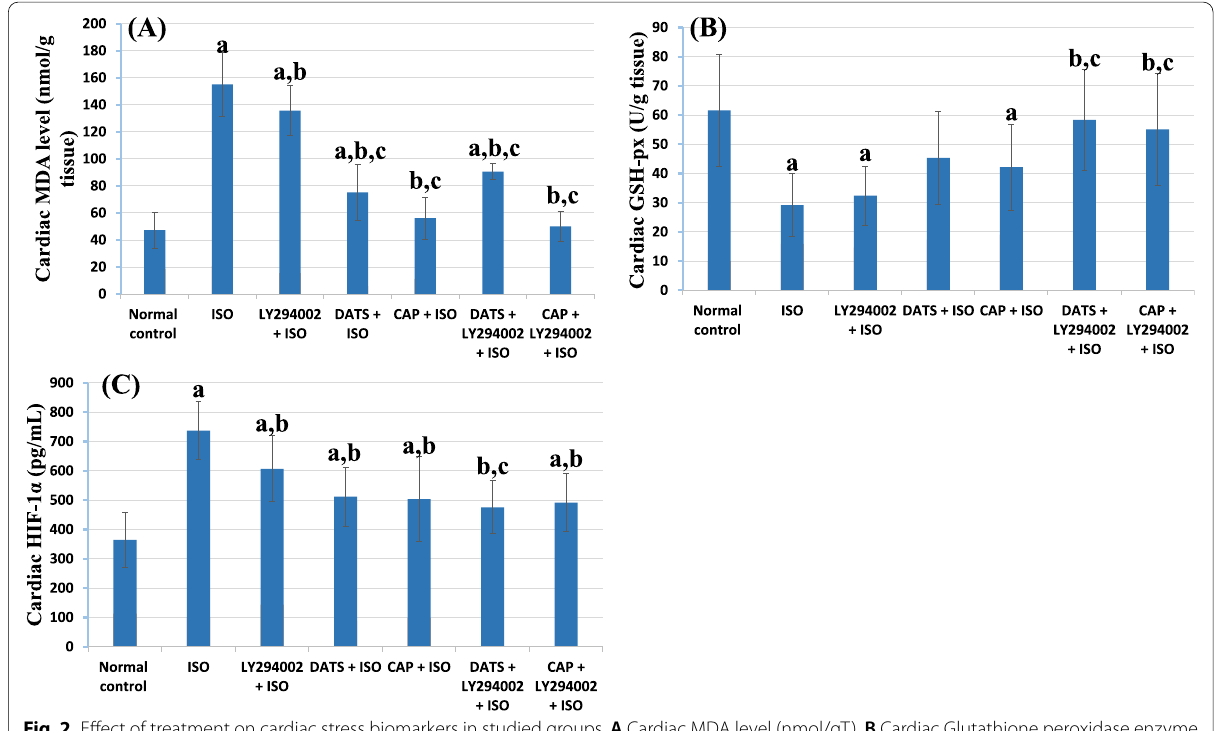
Fig. 2 Effect of treatment on cardiac stress biomarkers in studied groups. A Cardiac MDA level (nmol/gT). B Cardiac Glutathione peroxidase enzyme Activity (U/gT). C Cardiac HIF‑1α concentration (pg/mL). Data are presented as mean versus normal control group. b: Significant versus ISO group. c: Significant versus LY294002 (85 mg/kg isoproterenol), LY294002 Captopril pretreated group (50 mg/kg), DATS and PI3K inhibitor pretreated